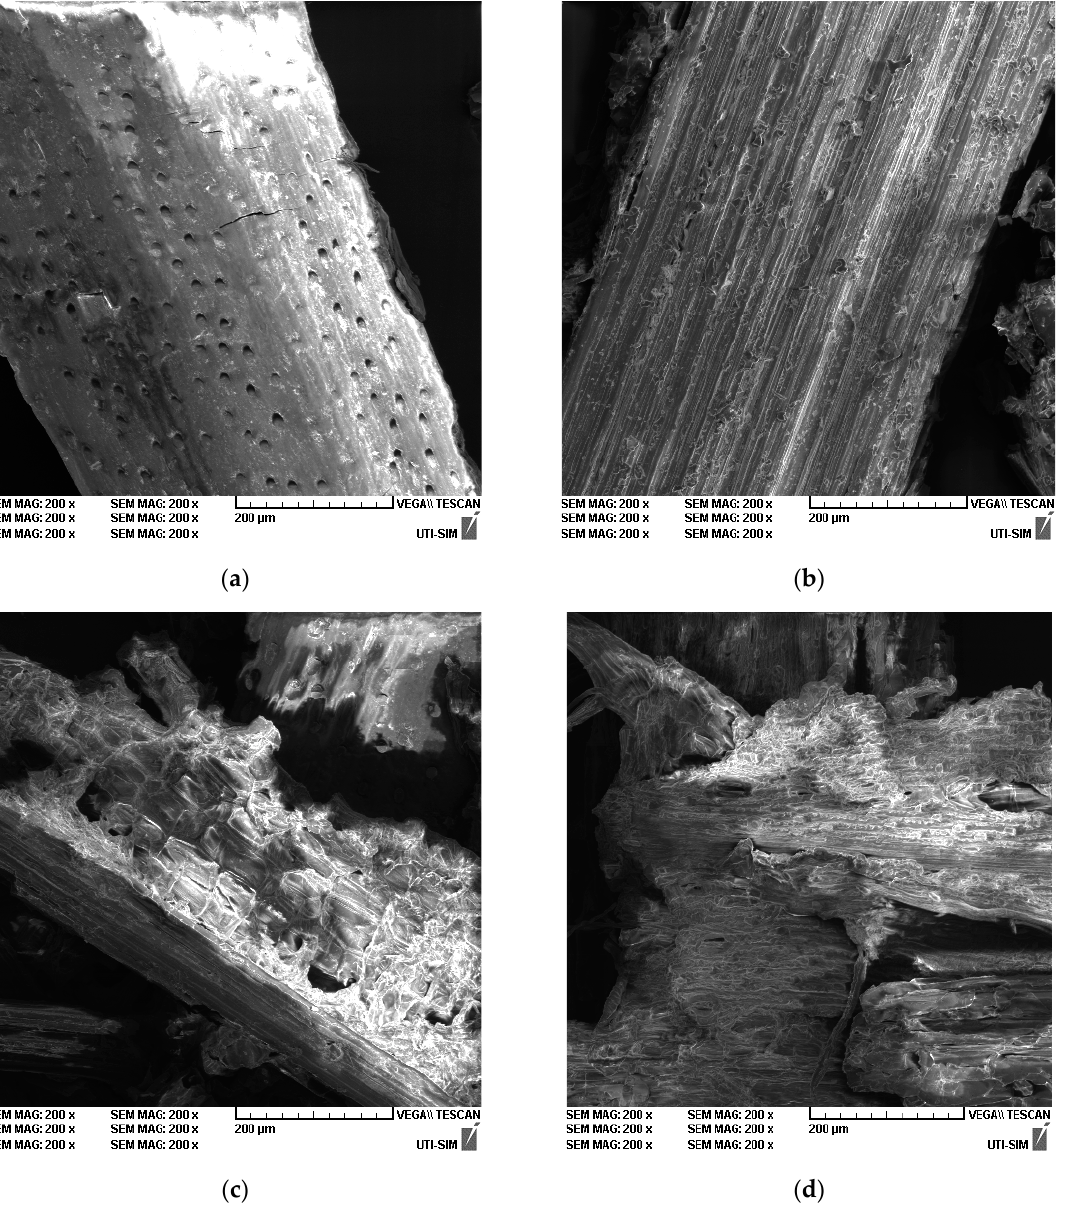
Figure 9. SEM images of wheat straw after various treatments: ( a ) wheat straw without any treatment; ( b ) wheat straw after alkali treatment; ( c ) wheat straw after the freeze–thaw cycle; ( d ) wheat straw after freeze–thaw and alkali